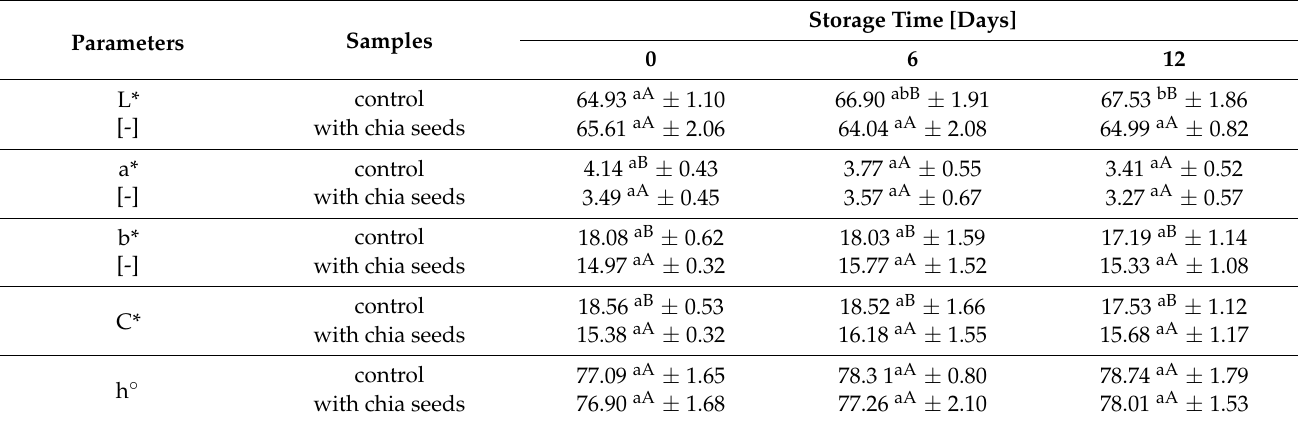
Table 3. Effect of chia seeds and storage time on the colour parameters on surface of pork patties (mean ± SD).